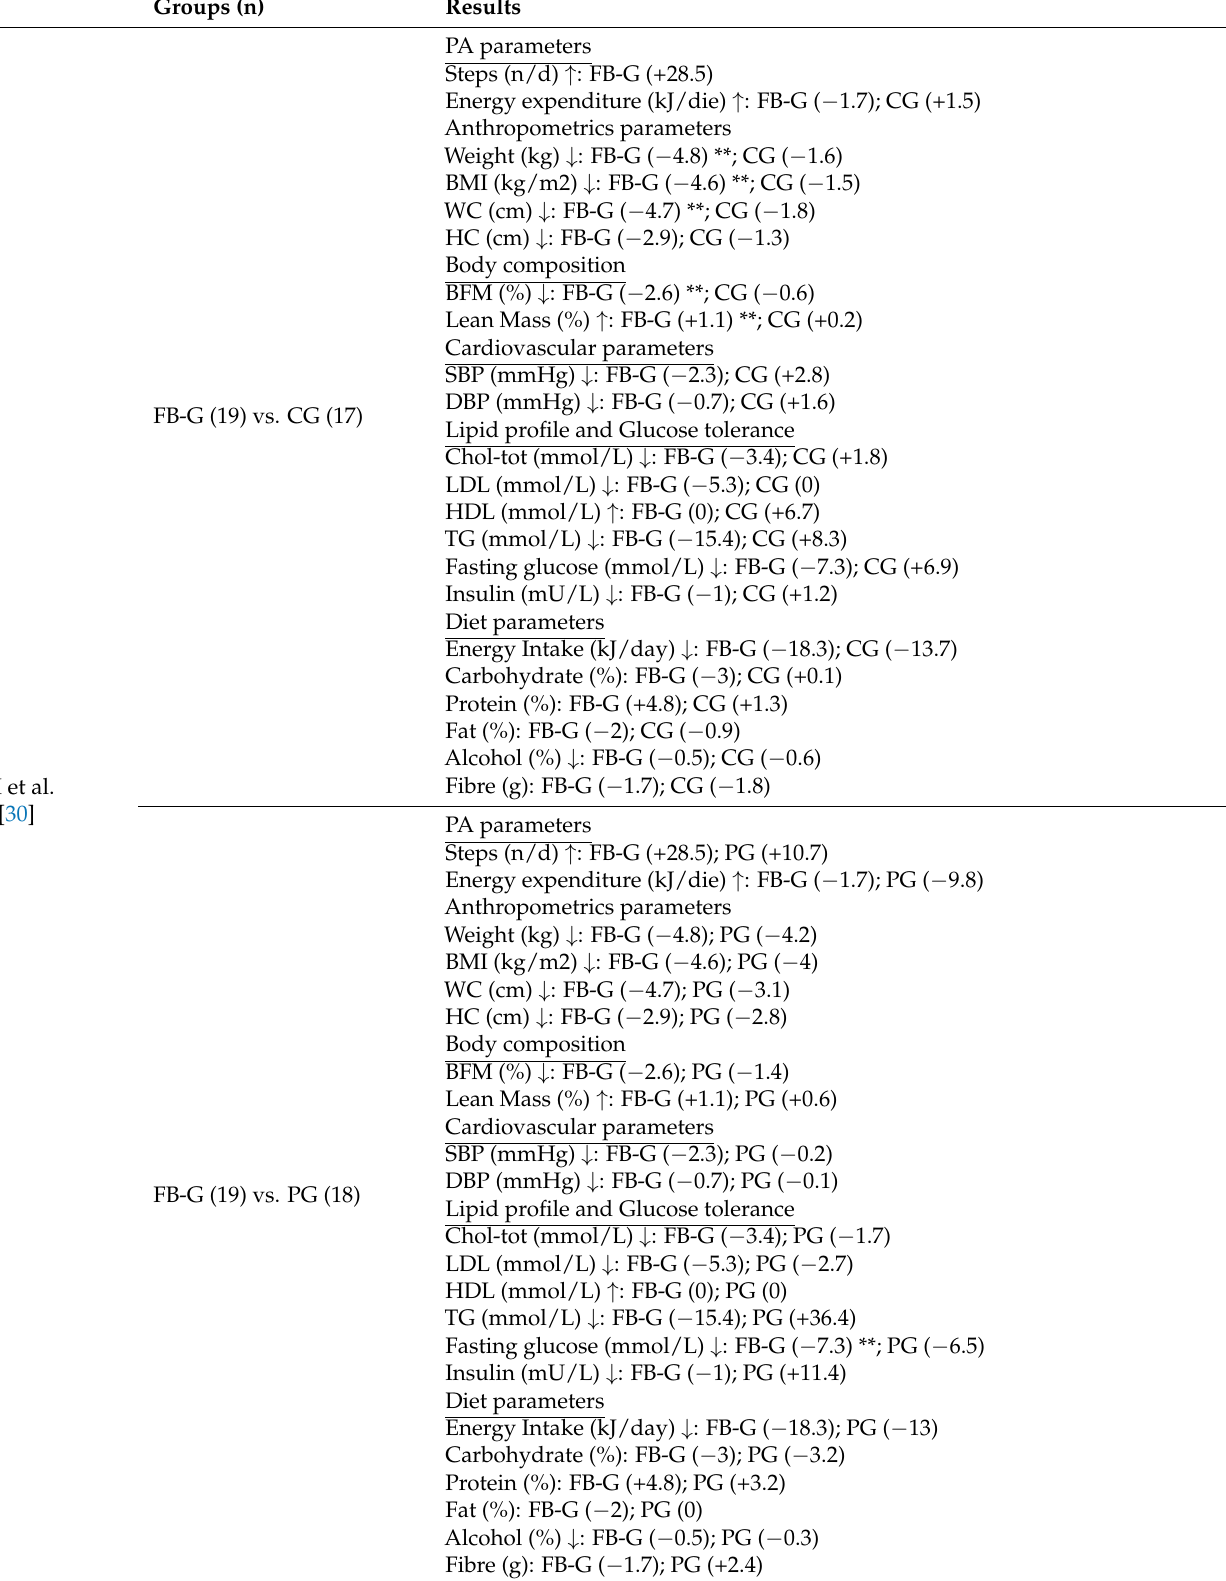
Table 4. Cont. Groups